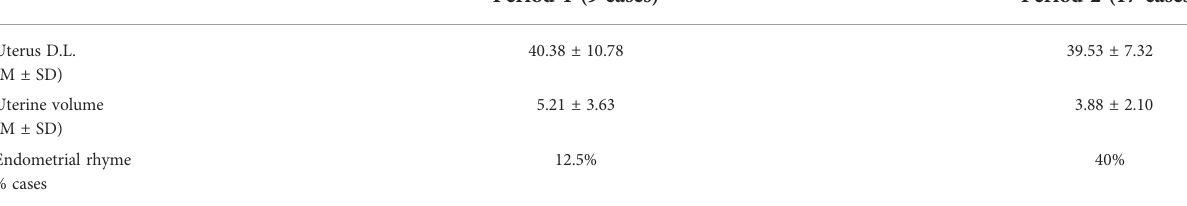
TABLE 4 Ultrasound (US) data at diagnosis in girls with CPP subdivided by observation period.